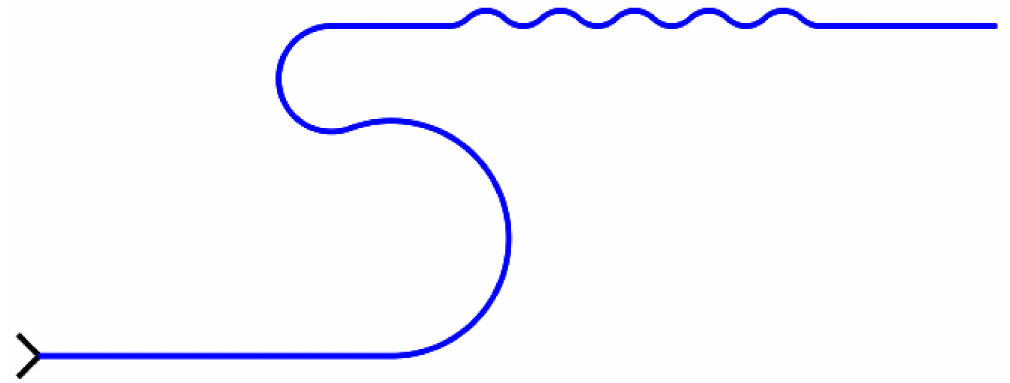
Figure 5. Simulation track configuration.